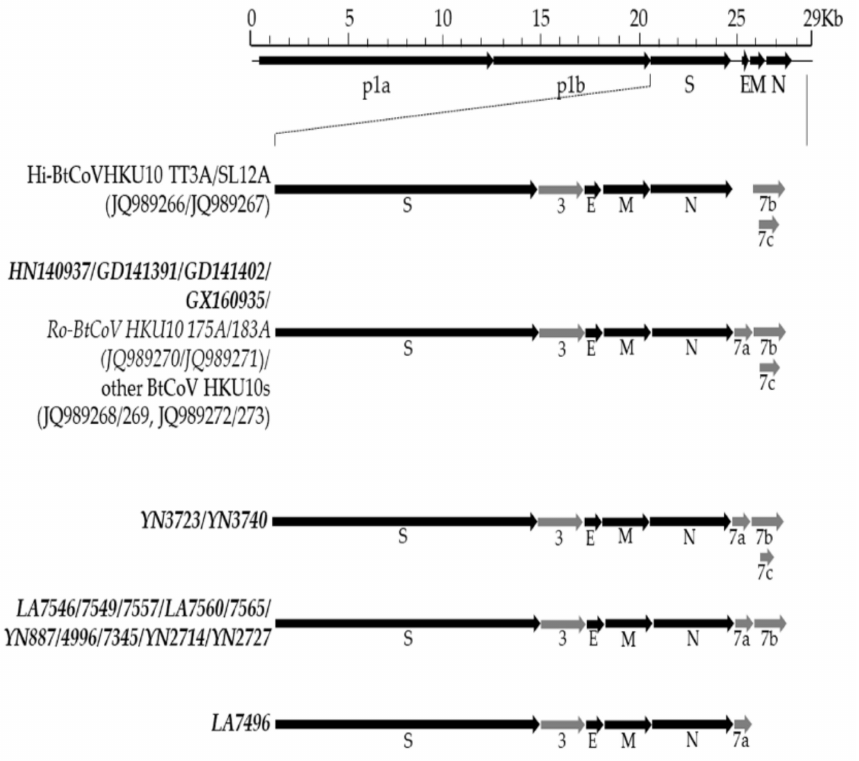
Figure 3. Schematic diagram of genomic organization of BtCoV HKU10 strains. The genomic regions or ORFs are described and compared in Supplementary Tables S3 and S4. Solid bars indicate conserved genes and grey letters indicate group-specific genes. Upper letters indicate structural proteins and lower letters indicate nonstructural proteins (p1a and p1b) and accessory